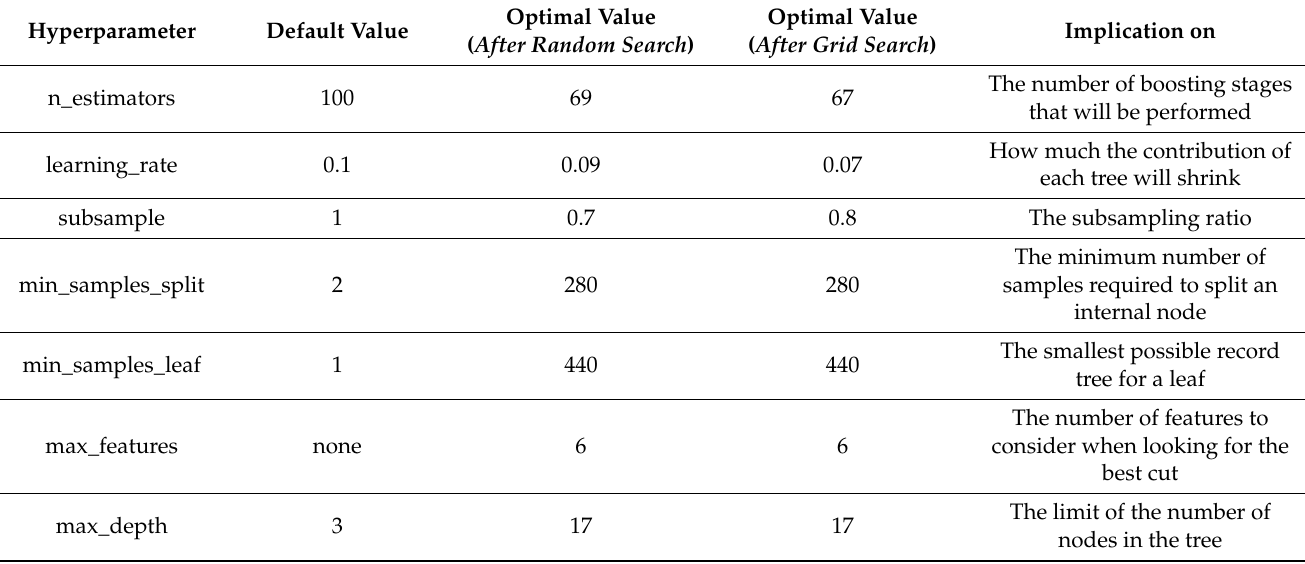
Table 1. The optimal values of hyperparameters determined for the RG_GBDT model.